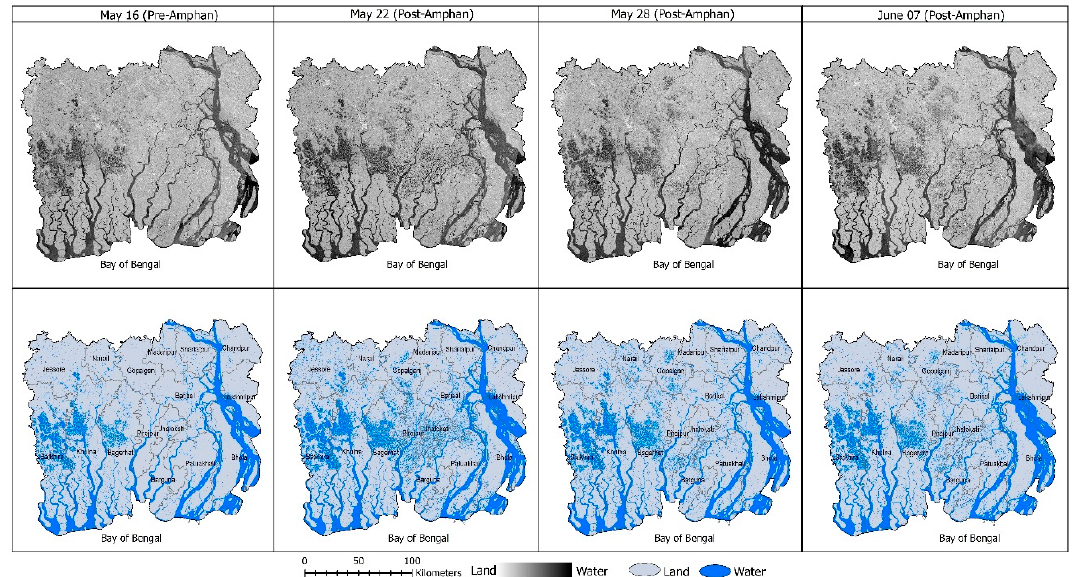
Figure 3. The top row of maps show the composite bands of vertical transmit and vertical receive (VV) and vertical transmit and horizontal receive (VH) polarizations of synthetic aperture radar (SAR) images, while the bottom row of maps are the classified SAR images of water and land corresponding to the images for 16 May, 22 May, 28 May, and 7 June.